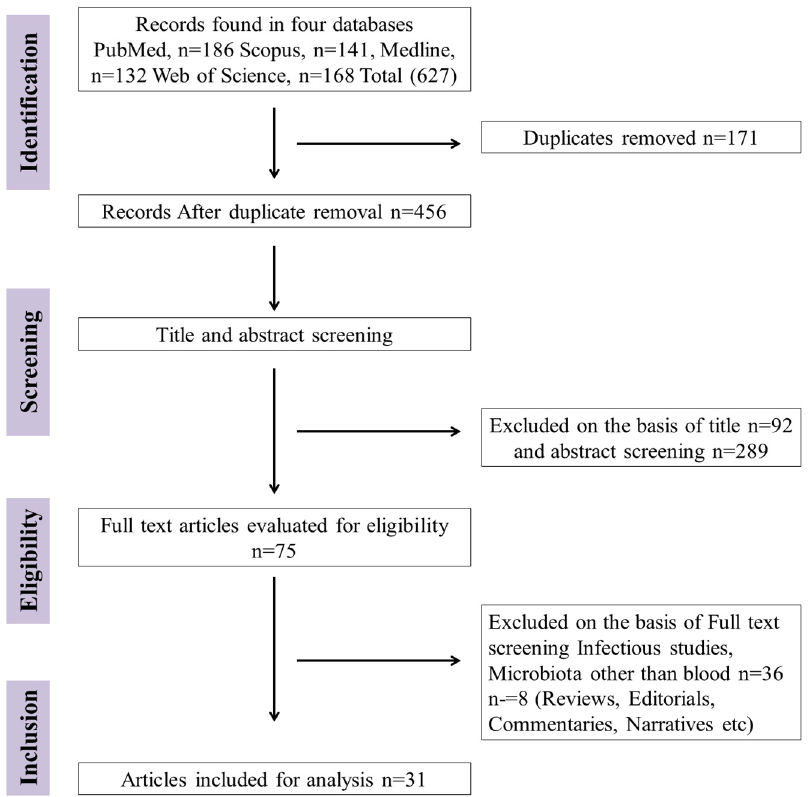
Figure 1. Flow diagram of studies searched in databases, screening exclusion and inclusion of studies (Preferred Reporting Items for Systematic Reviews and Meta-Analyses; PRISMA).